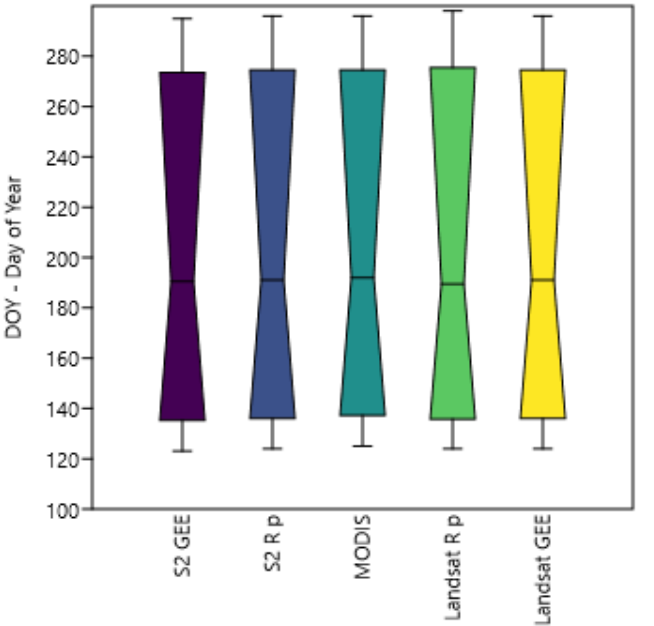
Figure 4. Boxplot considering all PMs computed in different software from different satellite sensors.